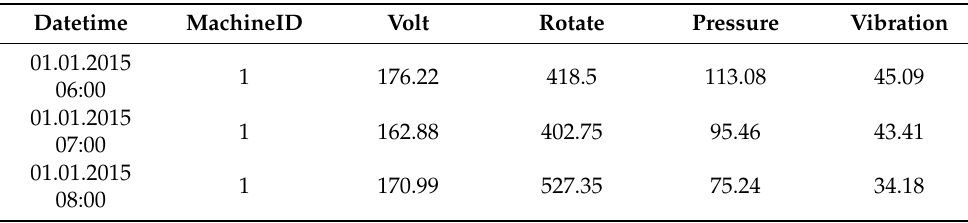
Table 1. An example of telemetry data in Use Case 1 with information about time (“Datetime”), machine (“machineID”), and the sensors data consisting of voltage (“Volt”), rotation (“Rotate”), pressure (“Pressure”) and vibration